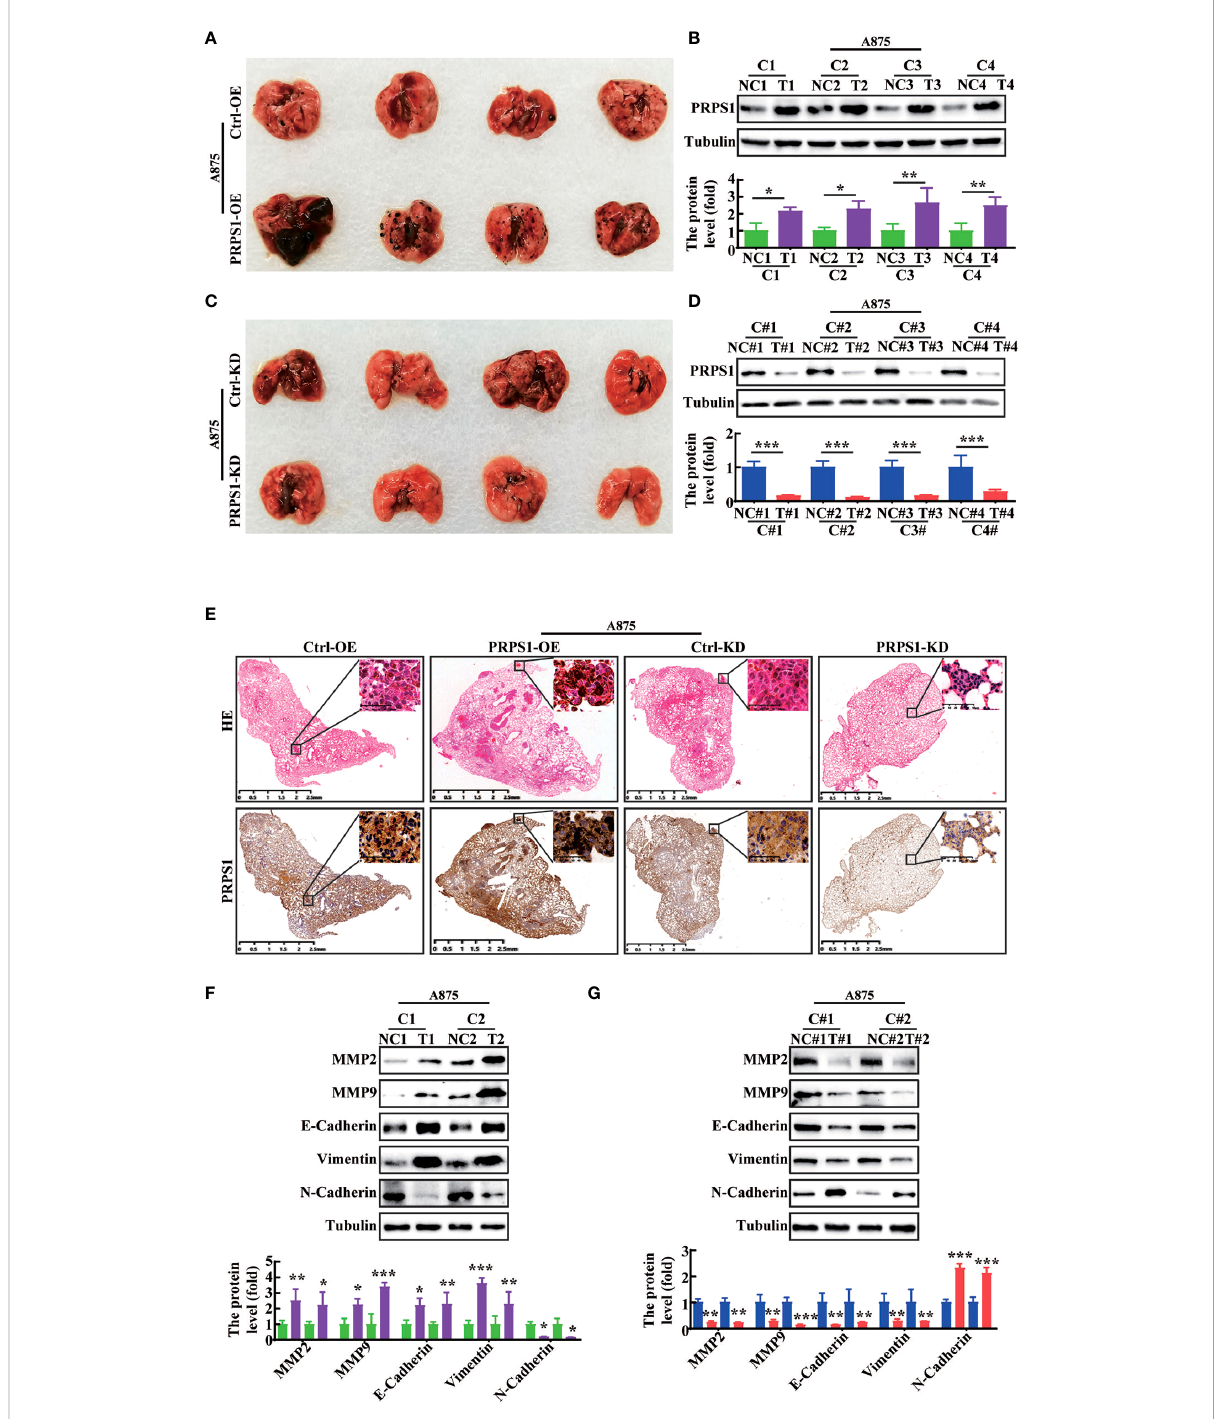
FIGURE 6 PRPS1 promotes melanoma cells metastasis in vivo. (A – D) In vivo experimental lung metastasis assay of A875 cells stably overexpressing (A) or knocking down PRPS1 (C) . The cells were injected into BALB/c nude mice via tail vein. Representative images of mice with the corresponding control (top) and PRPS1-overexpression/PRPS1-kockdown (lower) lungs metastasis. The expression of PRPS1 in PRPS1-overexpression and the control metastatic tumors (B) , as well as in the PRPS1-kockdown and the corresponding control metastatic tumors were compared by western blot analysis (D) . (n=6/group) (E) Morphological feature of the lung metastasis by HE staining and IHC in each metastatic tumor group. (F, G) The migration and invasion related protein levels in each metastatic tumor group were measured by western blot analysis. The data represent three independent experiments. Statistical analysis was carried out with unpaired-sample Student ’ s t test. * P < 0.05, ** P < 0.01, *** P <